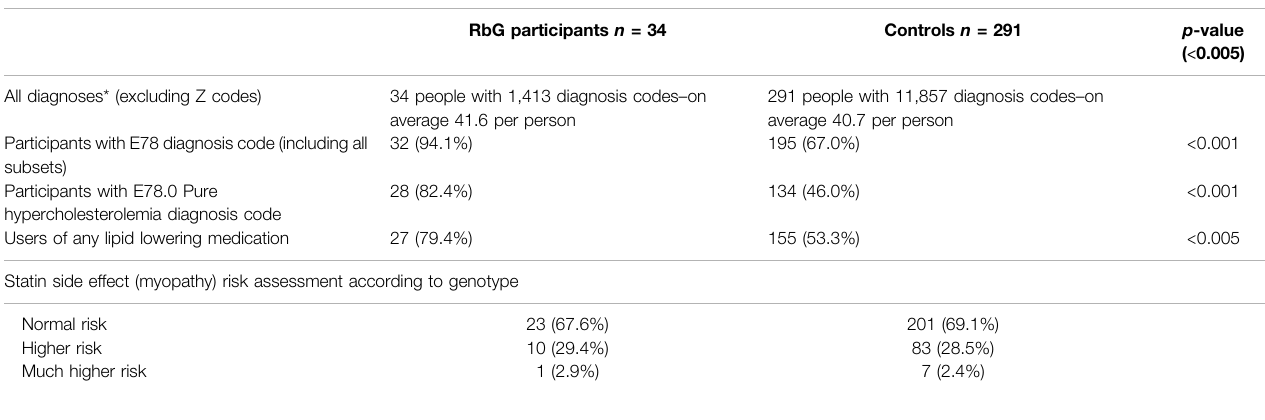
TABLE 3 | Principal FH-related fi ndings. The statin risk warning is applicable only for simvastatin, atorvastatin, and rosuvastatin. *ICD-10 codes were reduced to three characters, with each code counted only once for each